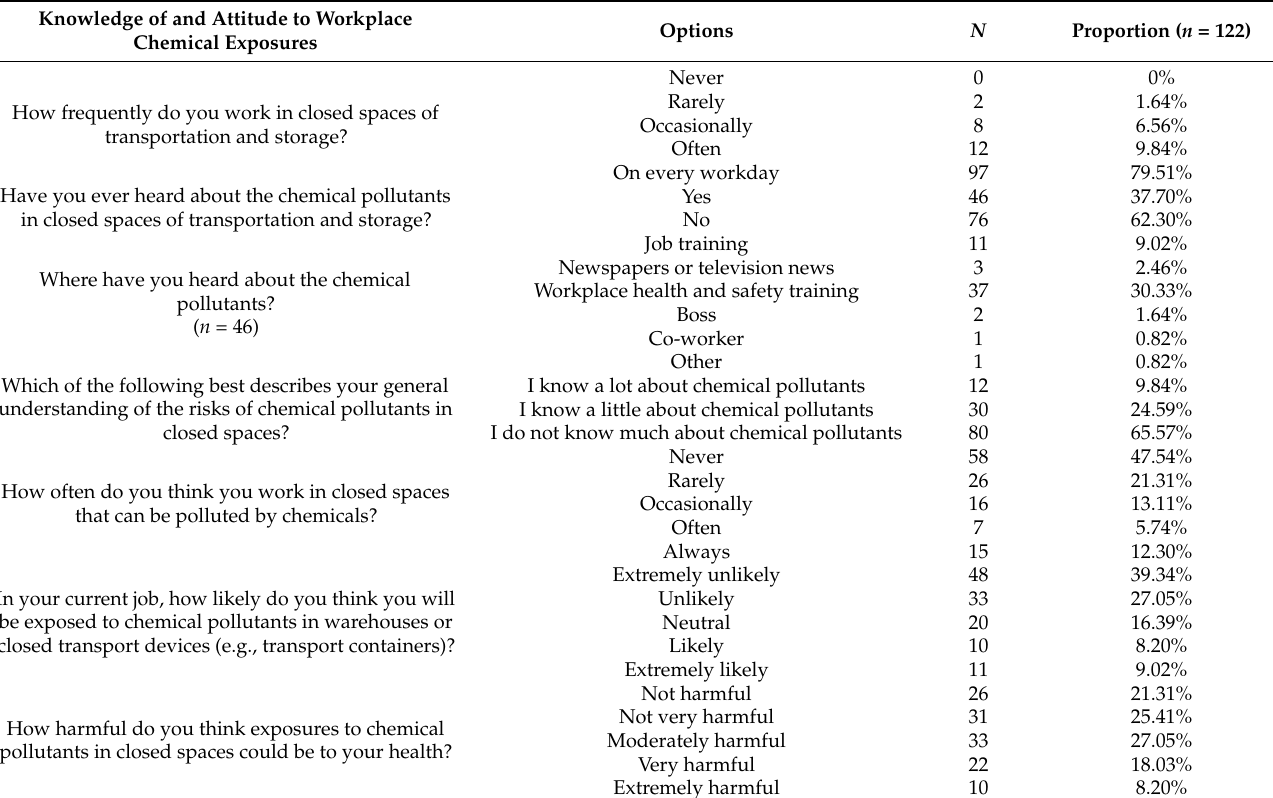
Table 4. Knowledge of and attitude to workplace chemical exposures among warehouse workers at logistics